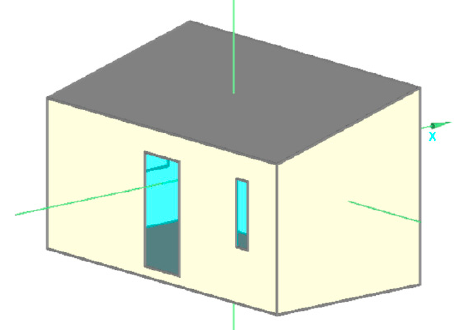
Figure 1. Building model in WUFI®plus software.